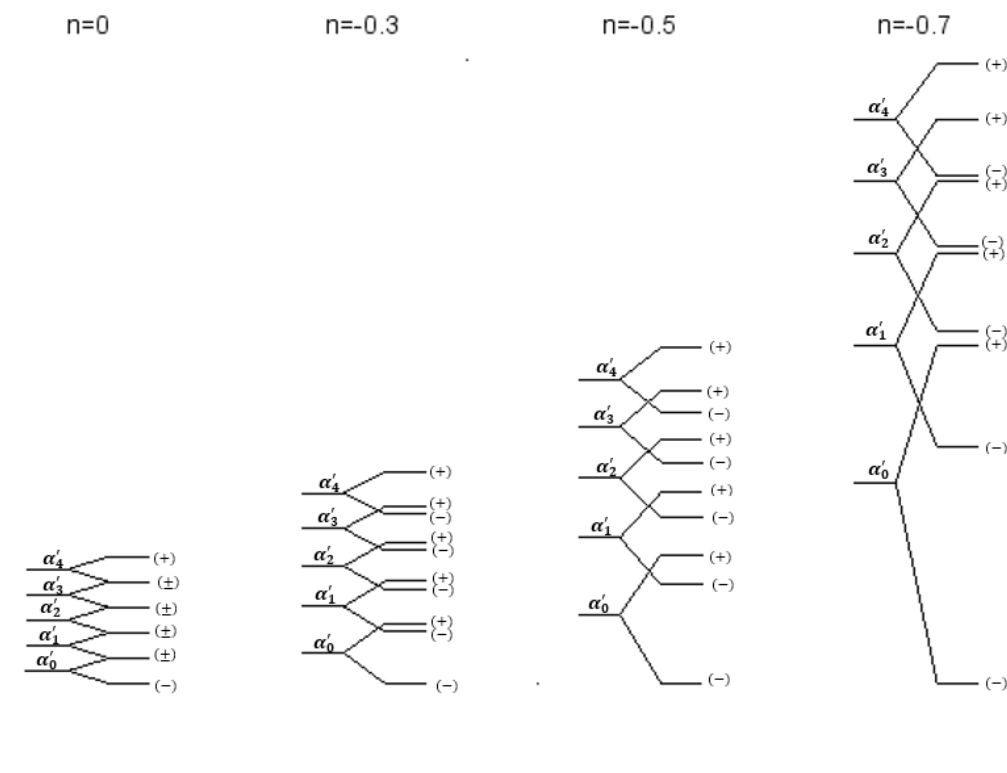
Figure 4: Schematic diagram showing splitting of energy levels with constant and varying magnetic fields for n = 0, − 0.3, − 0.5, −